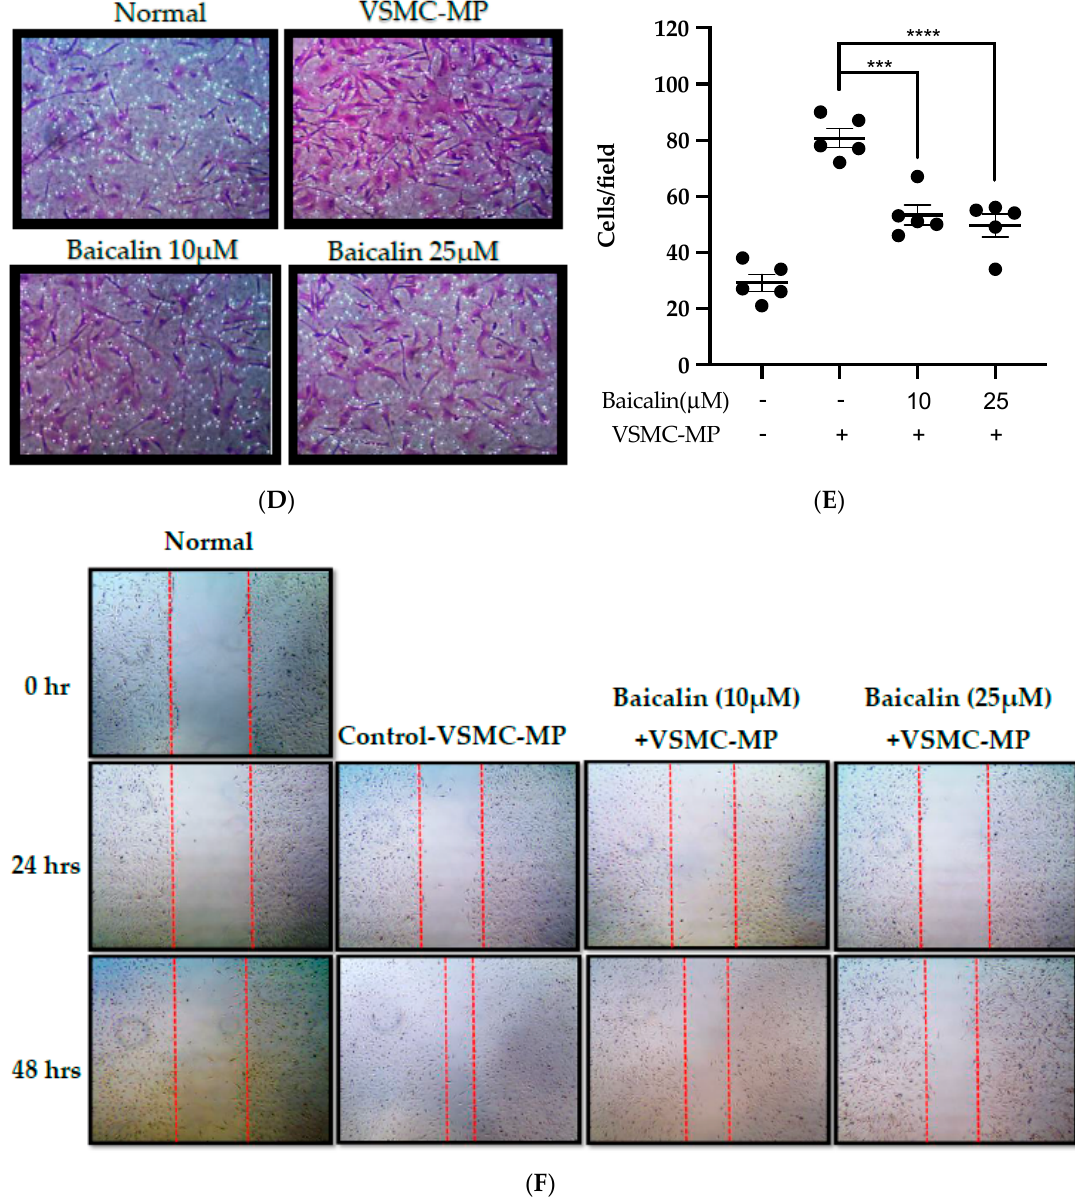
Figure 6. Effect of baicalin on VSMC-MP induced VSMC migration. VSMC were incubated with or without VSMC-MP and baicalin for 24 hours. ( A ) Cell supernatant media was subjected to gelatin zymography for the detection of MMP enzymatic activity. ( B ) Cell lysate was subject to Western blot for protein expression of MMP-9. β -actin was used for normalization. ( C ) Quantitative data of MMP-9-fold change. ( D ) VSMCs were induced to migrate through the gelatin membrane barrier in the presence of baicalin and VSMC-MP for 48 h. Images of migrated VSMC were taken after H/E staining (20× magnification). ( E ) The cells on the outer layer after migration were counted in five random positions under the high-power field (HPF). ( F ) The monolayer of confluent VSMC was scratched to create a migrating zone. Photographs were taken at time 0. Then, baicalin was treated at the concentrations of 10 and 25 μ M for up to 48 h in the presence of VSMC-MP. Photographs were taken at 24 h and 48 h (20× magnification). Each value is the mean ± SE of three to five independent experiments, and each independent experiment contains five replicates. *** p < 0.001, **** p < 0.0001 vs. control (VSMC -MP alone). The analysis was performed by one-way ANOVA followed by Dunnett multiple comparison test.